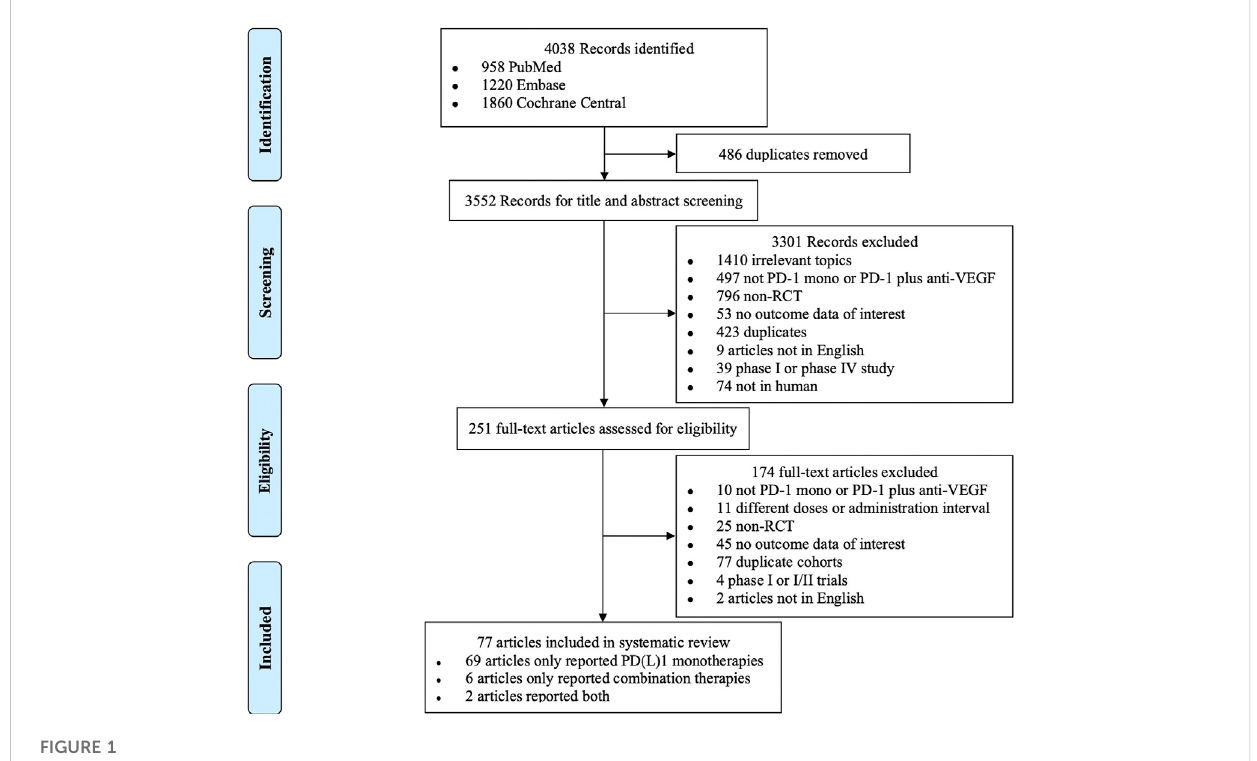
FIGURE 1 PRISMA fl ow